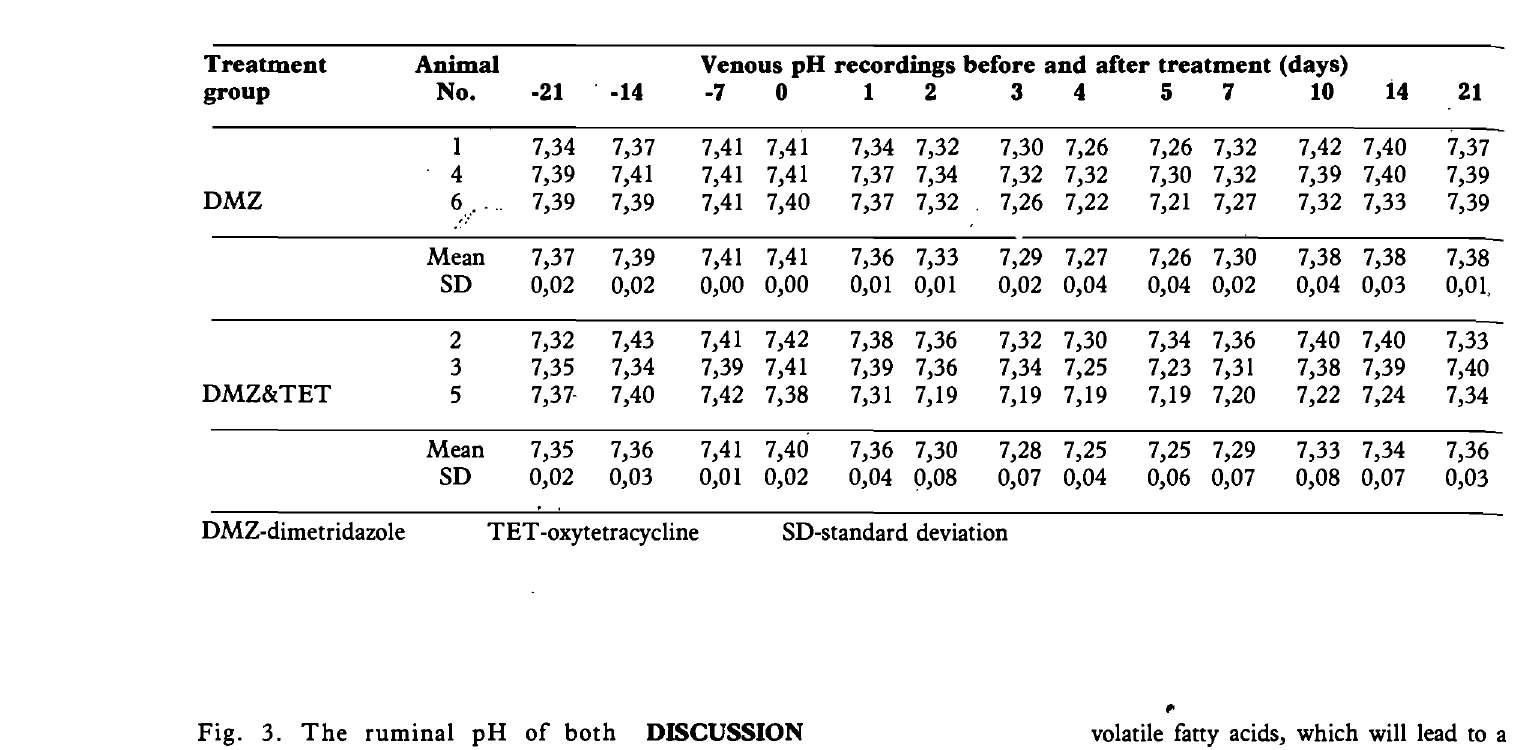
Table 1: Individual and mean (± standard deviation) venous pH recordings before and after treatment with either dimetridazole (DMZ) alone or in conjunction with oxytetracycline (DMZ&TET) in cattle Treatment Animal Venous pH recordings before and after treatment (days) group